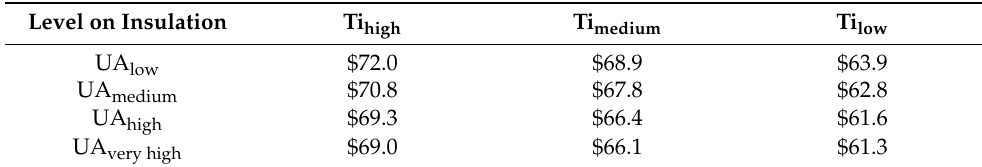
Table 14. Economic cost (values reported in USD) of reducing the DGFCH thermal efficiency by 1% for a heating season. Level on Insulation Ti high Ti medium Ti